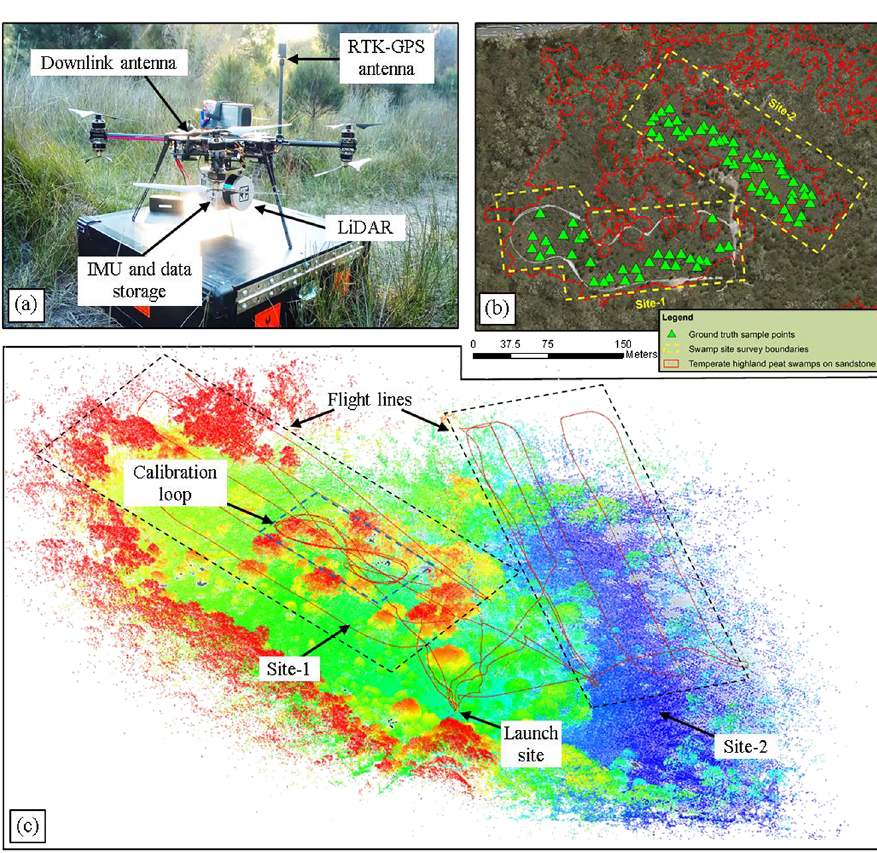
Fig. 2 a The integrated UAV-LiDAR system used in the study environment, b Map view of the study area with a detailed view of the swamp site survey boundaries (site-1 and site-2), ground truth sample locations (green triangles) and THPSS boundaries, and c 3D subsampled point cloud view with the calibration loop and flight lines for data